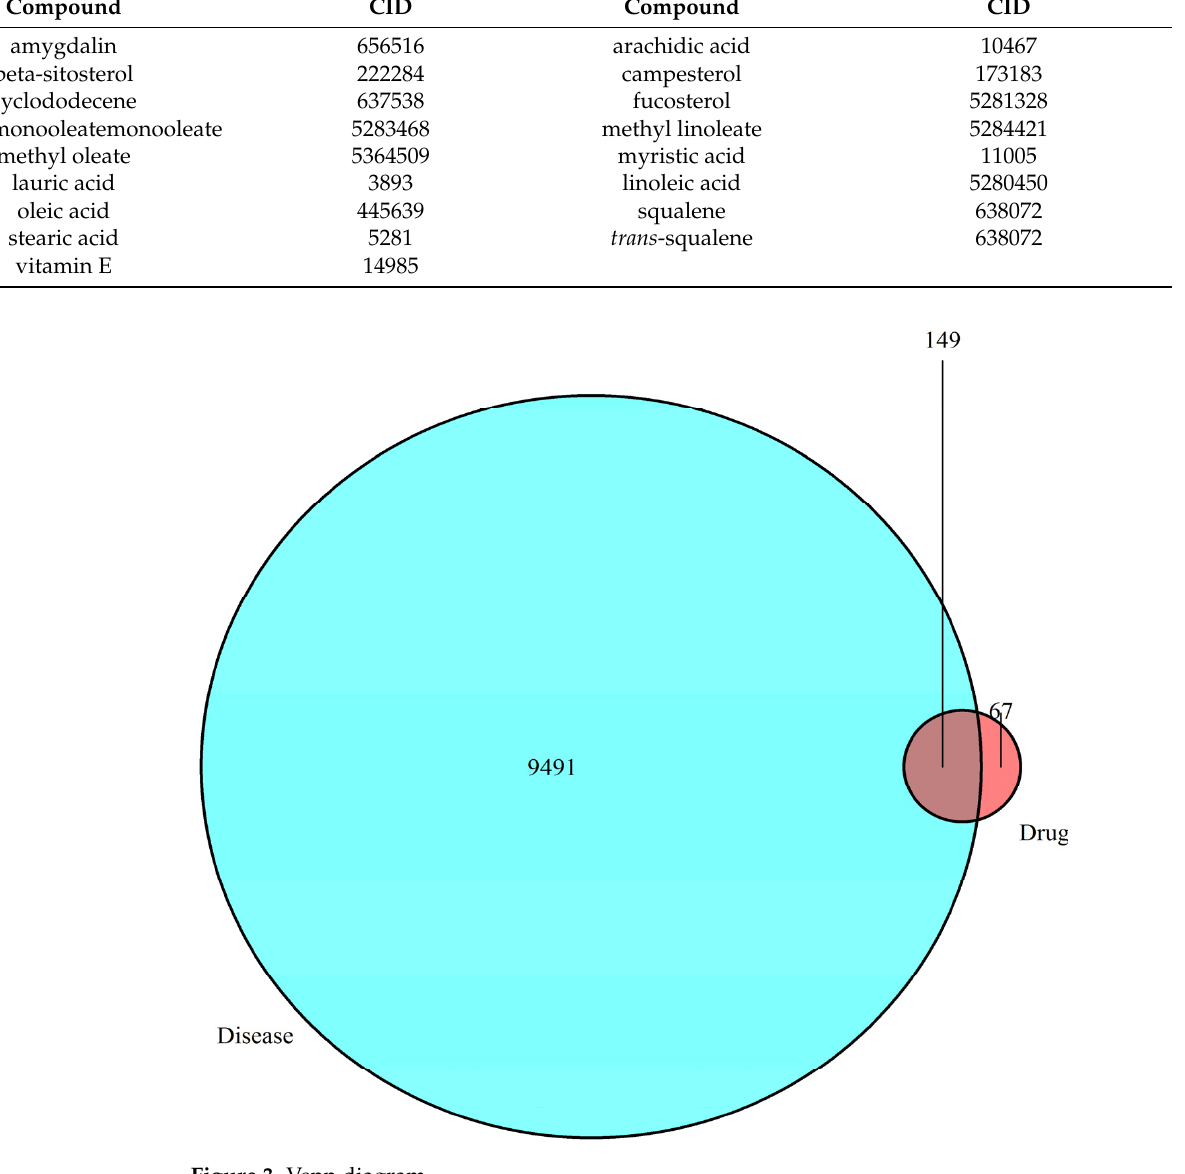
Figure 4. The kernel of P. mira -chemical composition-target-alopecia“ network analysis diagram.